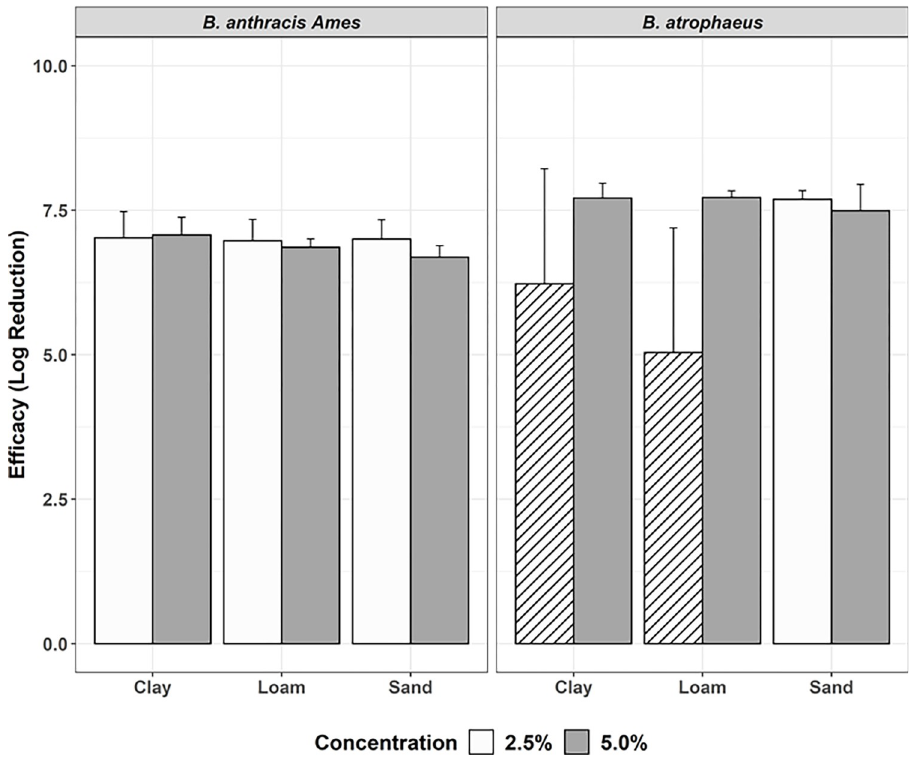
Fig 1. Efficacy of 2.5% (white; Test 2) vs. 5% (gray; Test 1) formaldehyde solutions. 2.8 mL, at ambient temperature, uncovered, against B . a . and B . atrophaeus , with efficacy represented by log reduction ( ± 95% CI) of bacteria, by soil type, and 48-hour contact time. Columns with stripes are samples that did not achieve complete